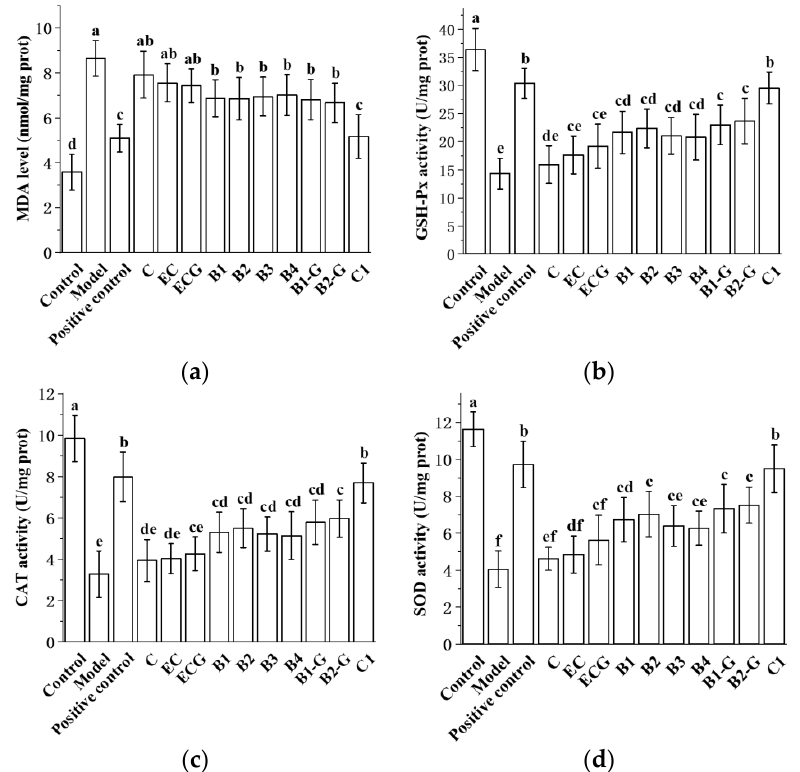
Figure 9. Effects of different structural procyanidins on oxidative stress in the zebrafish PD model. ( a ) MDA levels. ( b ) GSH-Px activity. ( c ) CAT activity. ( d ) SOD activity. Control, Blank control group; Model, MPTP (400 µM); Positive control, Deprenyl (40 µM) + MPTP (400 µM); C: C (25 µM) + MPTP